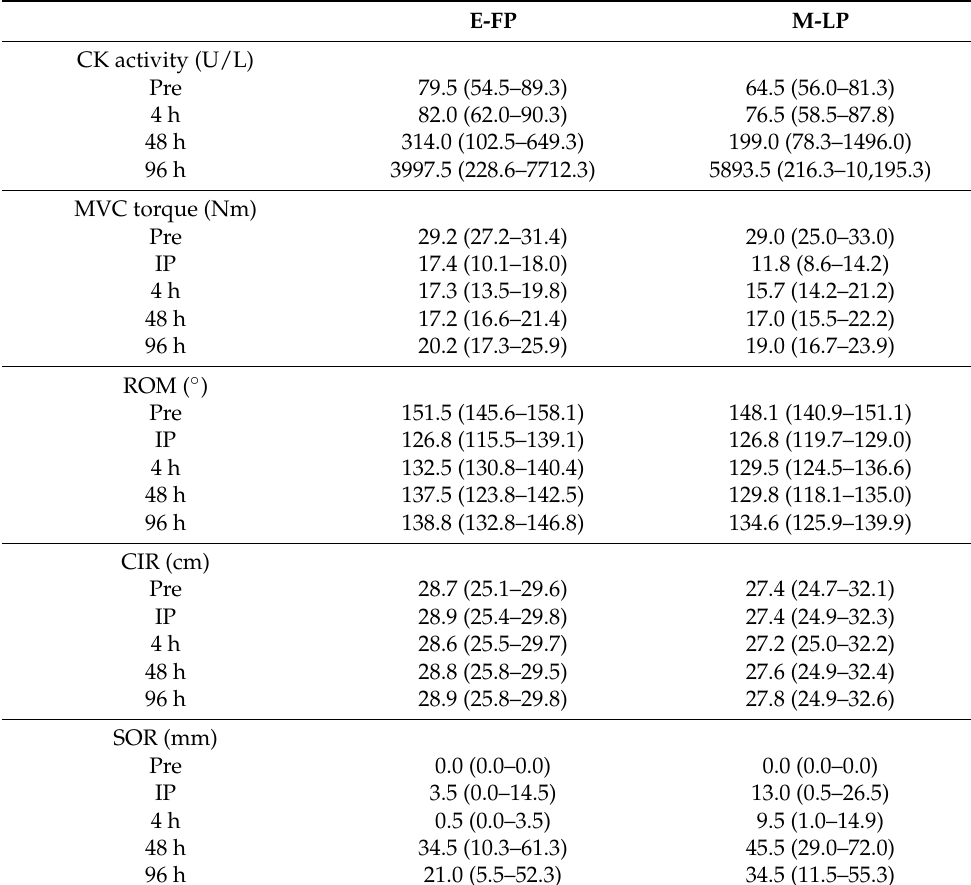
Table 3. Creatine kinase (CK) at pre- and 4, 48, and 96 h postexercise, maximal voluntary isometric contraction (MVC) torque, range of motion (ROM), circumference (CIR), and muscle soreness (SOR) at pre-; immediately post-; and 4, 48, and 96 h